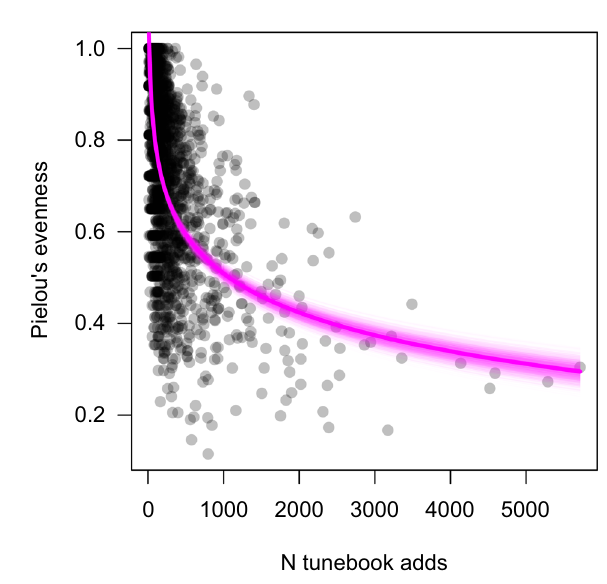
Fig. 3 Scatterplot showing the relationship between Pielou ’ s evenness and popularity ( N tunebook adds), across Session tunes ( n = 9378). The shaded area is made up of fi t lines from the entire posterior distribution, while the thick line is based on posterior mean effects. Fit lines were calculated with the time since tunes were uploaded to the site fi xed at the median value.